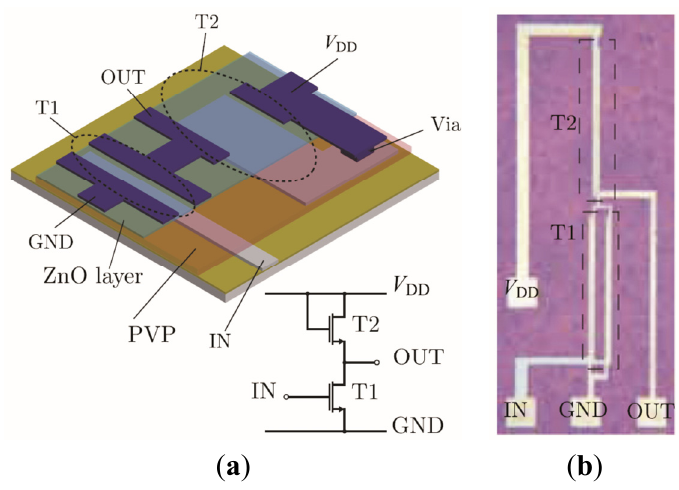
Figure 19. ( a ) Schematic graph, electrical representation and ( b ) an optical microscope picture of the inverter. Reprinted from [66], with permission from Elsevier.